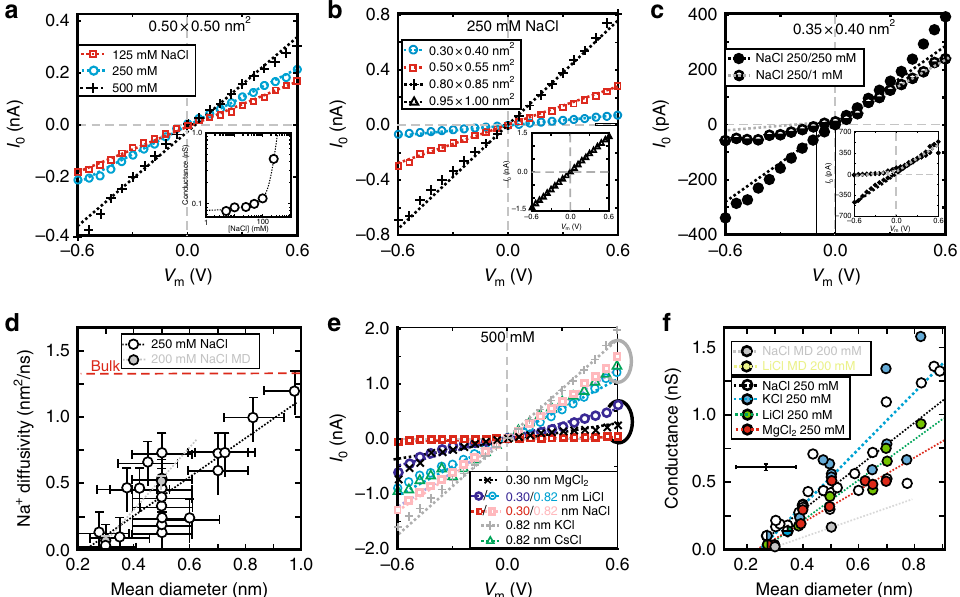
Fig. 2 Electrolytic ion transport through sub-nanopores. a A juxtaposition of the current-voltage characteristics acquired from the same sub-nanopore with a 0.50 nm mean-diameter using different concentrations of NaCl electrolyte. The dotted lines re fl ect FESs. Inset: The conductance of a pore with a mean- diameter of 0.52 nm as a function of NaCl concentration, illustrating a minimum conductance for concentrations <100 mM. The dotted-line represents a match to the data assuming a surface charge of − 0.19 e nm -2 . b Like a , but acquired from pores with 0.30 nm × 0.40 nm → )0.35 nm, (0.50 nm × 0.55 nm → )0.52 nm and (0.80 nm × 0.85 nm → )0.82 nm mean-diameters at the waist in 250 mM NaCl. Inset: Like b , but for a pore with a (0.95 nm × 1.00 nm → )0.97 nm mean-diameter. c The current – voltage characteristic of a sub-nanopore with a mean-diameter of (0.35 nm × 0.40 nm → )0.37 nm measured with 250 mM NaCl on both sides of the membrane (open circles), and then with a gradient across the membrane with only 1 mM NaCl on the trans -side (half- fi lled circles). The asymmetric conductance indicates that >97% of the current was carried by Na + . Inset: Like c , but for a pore with a mean-diameter of (0.75 nm × 0.85 nm → )0.80 nm. Here, 90% of the current was carried by Na + . d The dependences of the diffusivity extracted from FES on the mean- diameter of sub-nanopores for Na + in 250mM NaCl (open circles). The best- fi t (black dotted) line extrapolates to zero diffusivity near a 0.22 nm-mean- diameter. For comparison, juxtaposed on the same plot is the diffusivity extracted from MD using model sub-nanopores with 0.30 nm and 0.50 nm diameters (gray circles). e Like a , but acquired from two sub-nanopores with (0.80 nm × 0.85nm → ) 0.82 nm (gray lasso) and 0.30 nm (black lasso) mean-diameters using different electrolytes at 500 mM. f The dependences of the conductance on the mean-diameter of sub-nanopores for four different electrolytes at 250 mM. The best- fi t lines for the metal ions extrapolate to zero conductance at 0.21 ± 0.11 nm for Na + ; 0.24 ± 0.11 nm for K + ; 0.26 ± 0.11 nm for Li + and 0.23 ± 0.11 nm for Mg 2 + , near to a 0.24 nm-diameter. For comparison, juxtaposed on the same plot are the conductances extracted